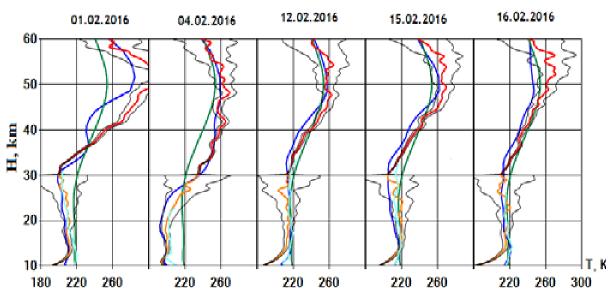
Fig. 6. Lidar and satellite observations of